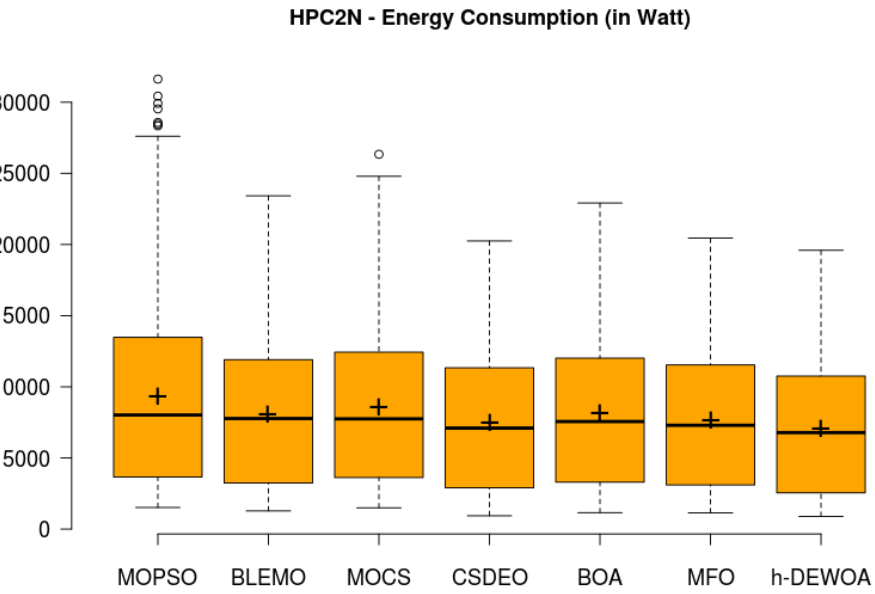
Figure 19. Comparative boxplot of the overall energy consumption of h-DEWOA and recent state-of-the-art algorithms for HPC2N workloads.